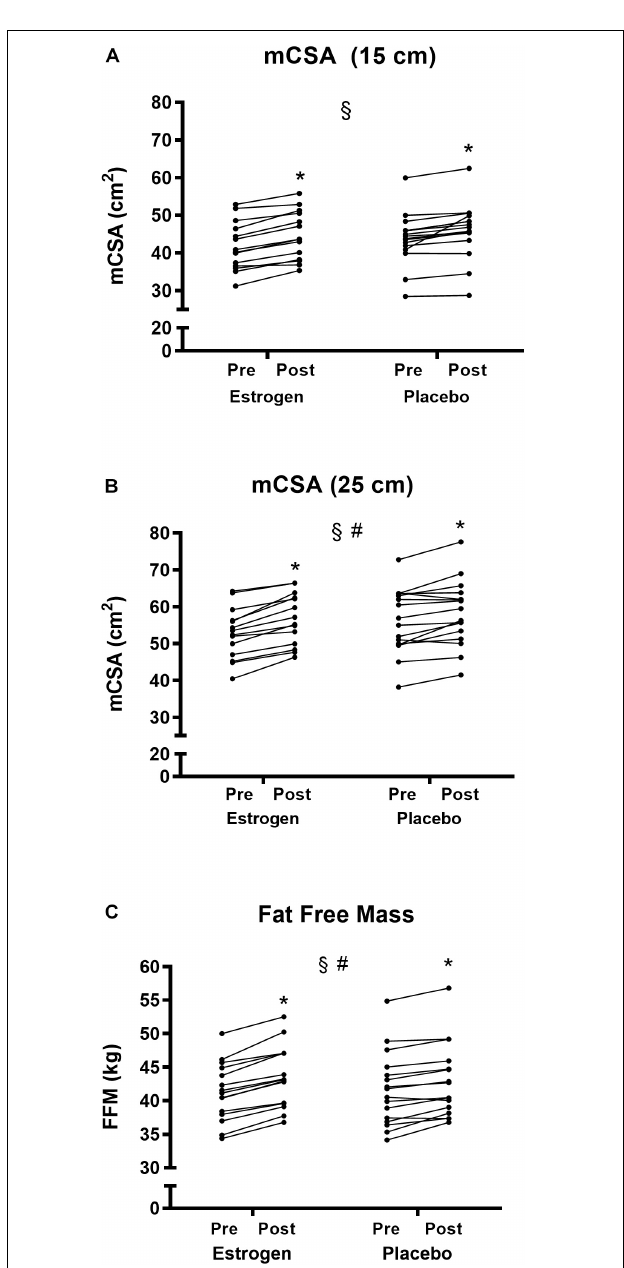
FIGURE 3 | (A) Muscle cross-sectional area determined 15 cm above patella plateau (mCSA 15 cm) (B) mCSA determined 25 cm measured by magnetic resonance imaging and (C) Whole-body fat-free mass measured by dual-energy-x-ray absorptiometry before and after 12 weeks of resistance training in the individual participants in the ET and PLC groups, respectively. # Group × time interaction ( p < 0.05). § Training effect ( p < 0.05). *Different from pre- in the individual group ( p <